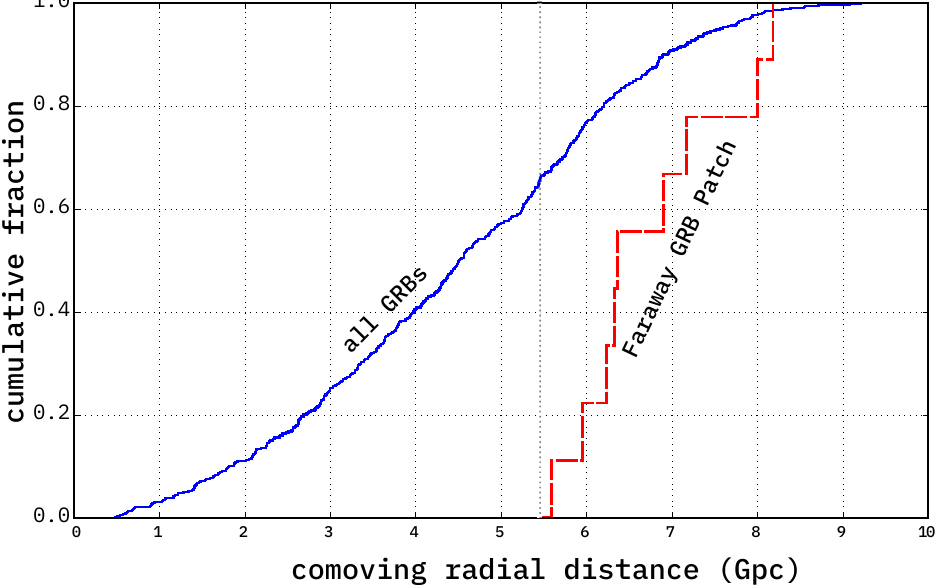
Figure 2. The comoving radial distance distribution of all GRBs in our dataset (except the nearest 500 Mpc observations). There is almost a linear trend between 4 and 6 Gpc ( z ≈ 1.3–2.5), where the GRB density is the highest. The radial distribution of the Faraway GRB Patch (q.v. Section 4.1) is also shown: here, all distances are from afterglow observations